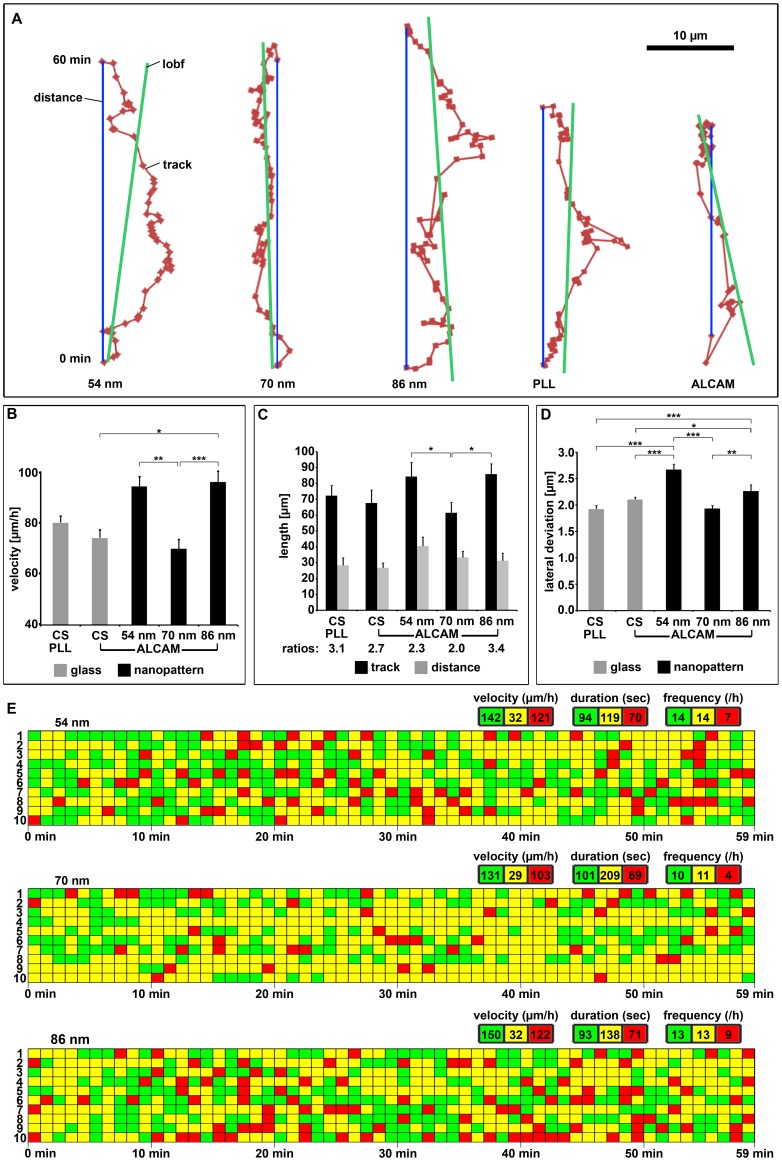
Growth cone behavior on various substrates.(A) Growth cone tracks (dark red) on ALCAM nanopatterns or PLL-/ALCAM-coated glass as observed by time-lapse phase contrast microscopy. Each dot represents the position of the growth cone neck (localized every minute); the blue line depicts the distance covered within the 60 min observation time and the dark green line the line of best fit (lobf, overall growth direction). For additional tracks, see Supplemental Figure S2. (B) Quantification of growth cone velocity (determined every minute as advance on line of best fit) on PLL-/ALCAM-coated glass or on ALCAM nanopatterns for ten growth cones each. (C) Quantification of track lengths and distances (see A) on various substrates for ten growth cones each. (D) Quantification of the lateral track deviations from the distance line (see A) per minute on various substrates for ten growth cones each. (E) Growth cone behavior, i.e. advance, pause, and retraction (green: >1 µm/min, yellow: −1 to +1 µm/min, and red: <−1 µm/min, respectively) on various ALCAM nanopatterns of ten different axons each, plotted for 60 min. Velocity, duration, and frequency of the three types of behavior were determined with respect to the line of best fit. For growth cone behavior on PLL/-ALCAM-coated glass, see Supplemental Figure S3. Error bars represent SEM; for statistical analyses, two-way ANOVA followed by post-hoc comparisons using two-tailed Student's t test with Bonferroni-Holm corrections were performed (***P<0.001, **P<0.01, *P<0.05).